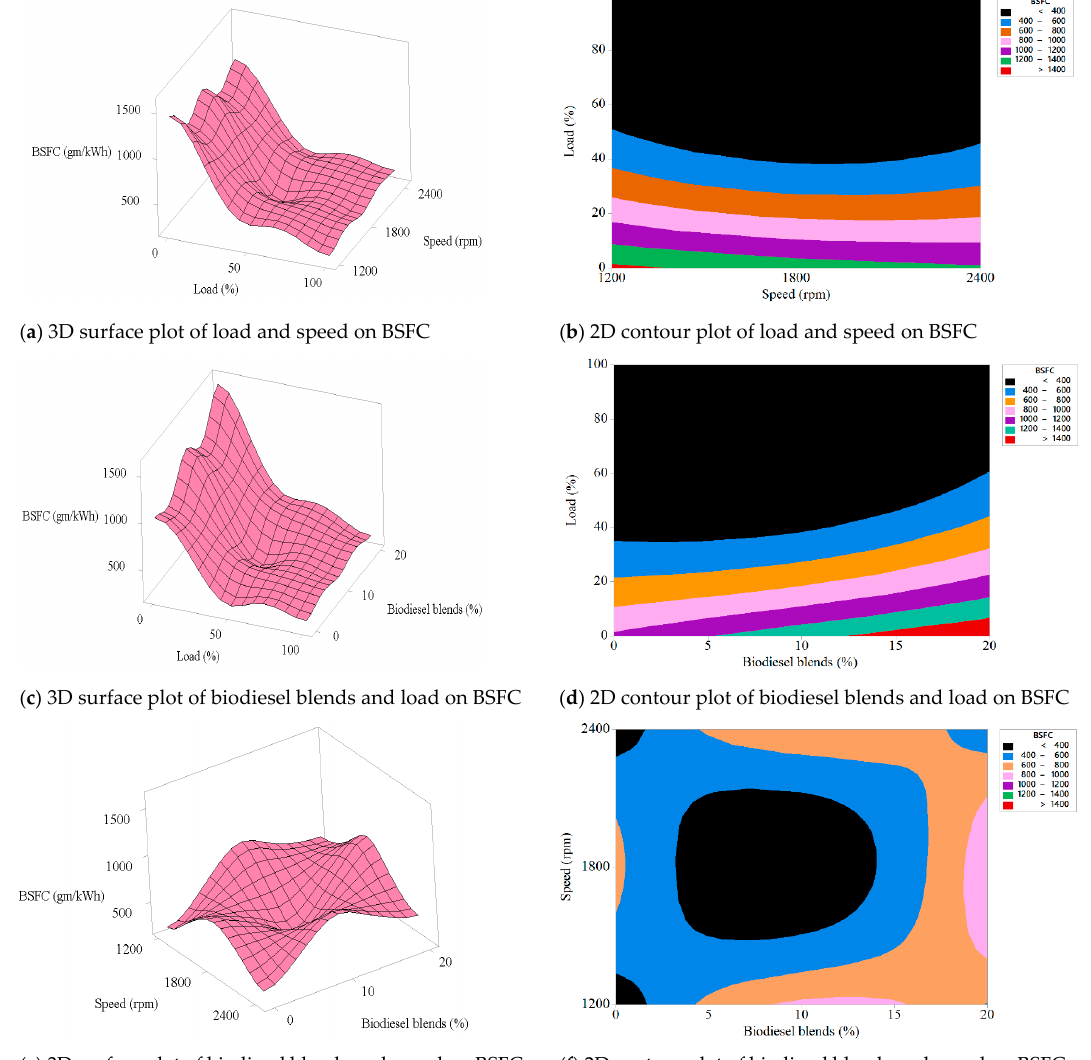
Figure 8. Combined effects of biodiesel blends, load, and speed on BSFC